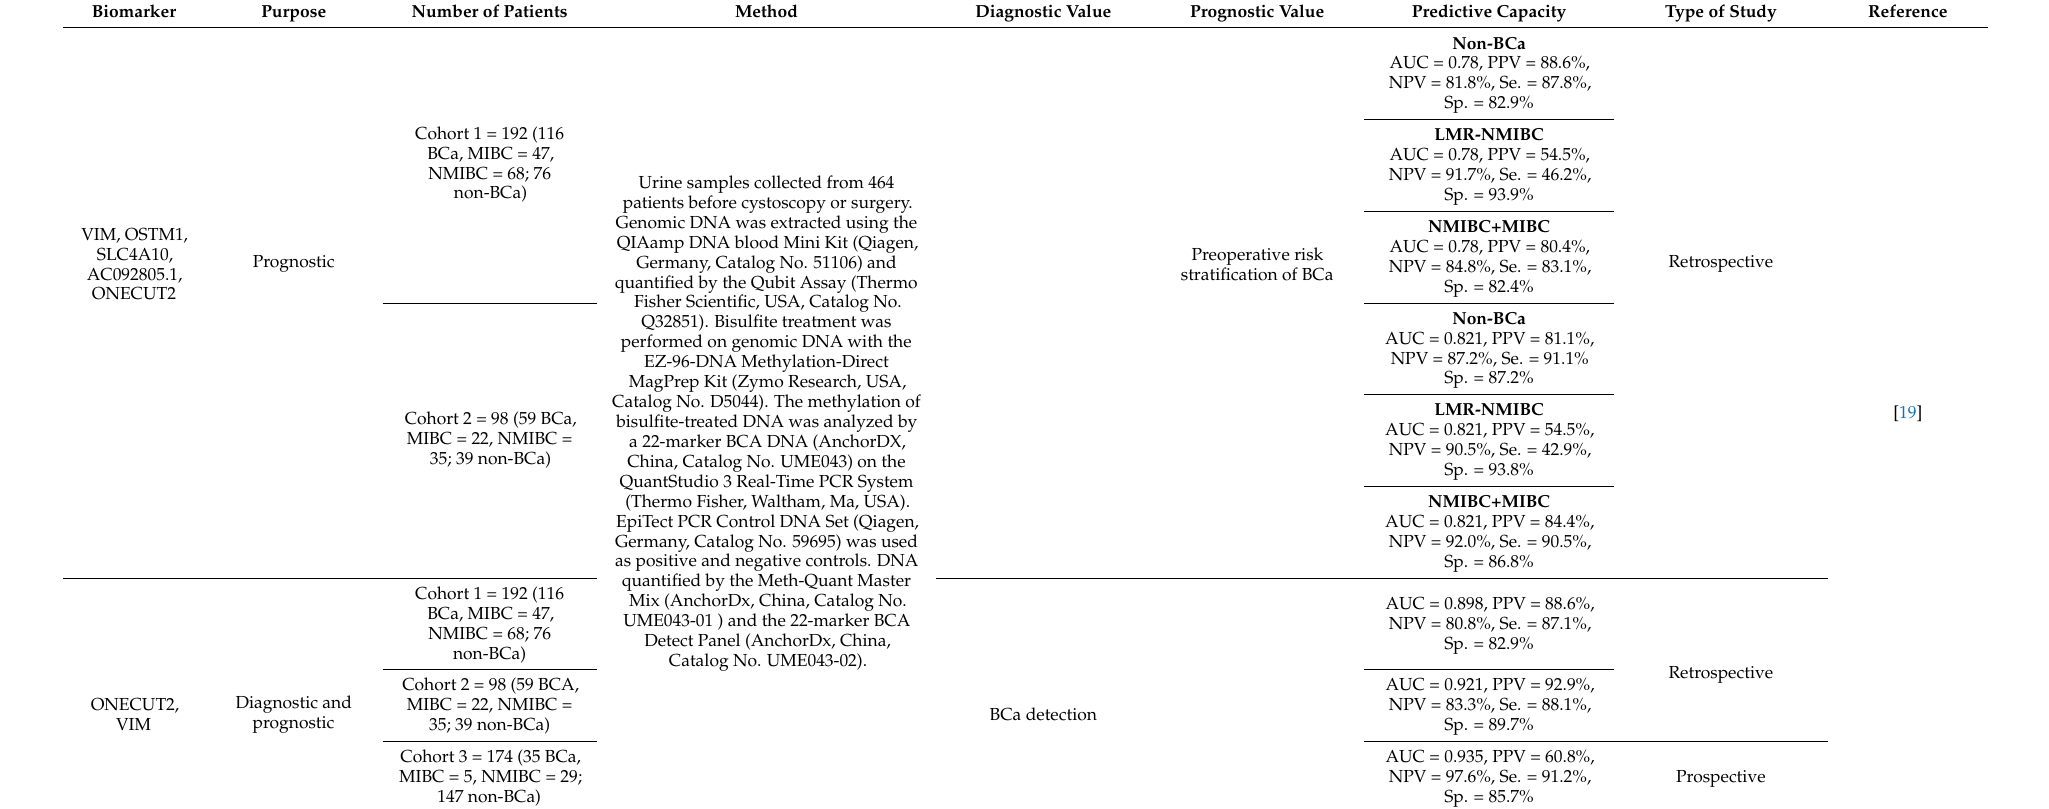
Table 1. Table presenting data for methylation